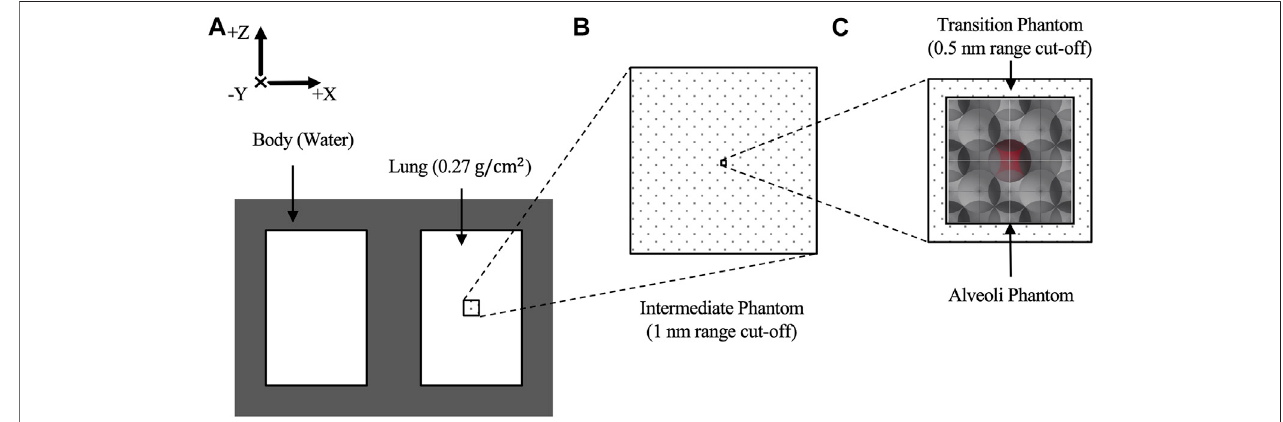
FIGURE 2 | (A) Schematic layout of generic chest phantom consisting of a body and lungs. (B) The right lung contains an intermediate volume where the phase space “ 2 ” wascollected.Withintheintermediatevolume, (C) atransitionvolumeencasesthealveolimodel.Thecentralalveolus,shadedinred,has16energydeposition scorers attached to its water